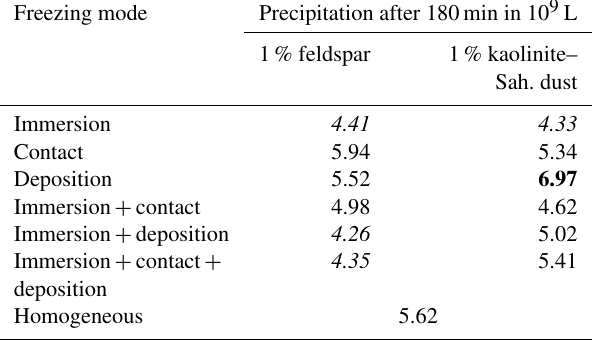
Table 5. Total precipitation after 180min of modeling time for cou- pled homogeneous, immersion, contact, and deposition freezing in various combinations. Marked in bold: cases with more than 20% enhancement of precipitation. Marked in italics: cases with more than 20% reduction of